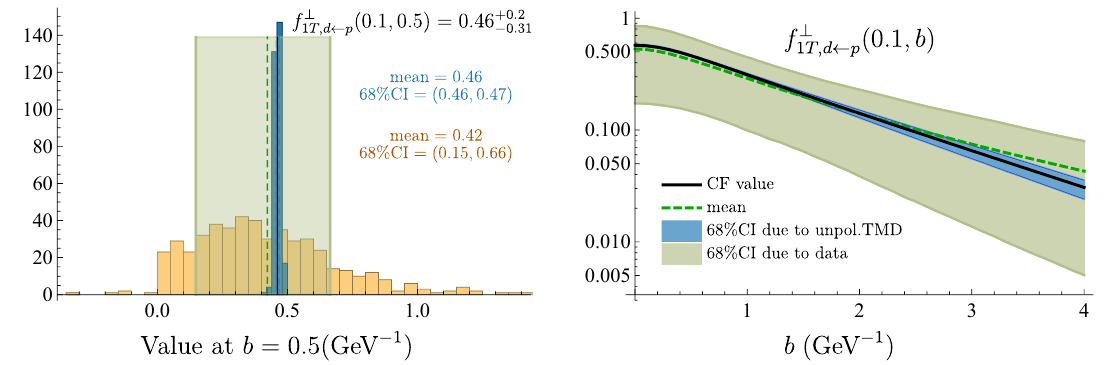
Figure 4. An example of evaluation of an observable (here it is the optimal Sivers function for d -quark at x = 0 . 1 as a function of b ). The observable is computed for all sets of replicas for each point (an example of the distribution at b = 0 . 5 (GeV − 1 ) is shown in the left panel). The color notation is the same as in figure